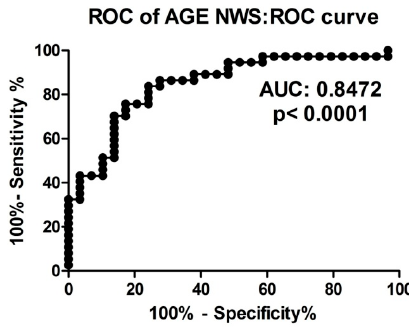
Figure 5. ROC analysis of AGE content in non-stimulated saliva of dementia patients compared to healthy controls. Abbreviations: AUC, area under curve; NWS, non-stimulated whole saliva; ROC, receiver operating characteristic.